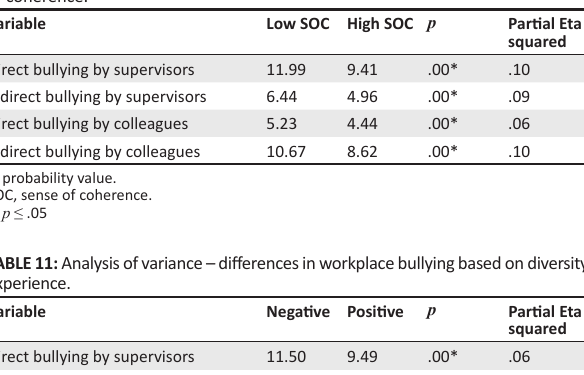
This is consistent with the findings of Niedhammer et al .